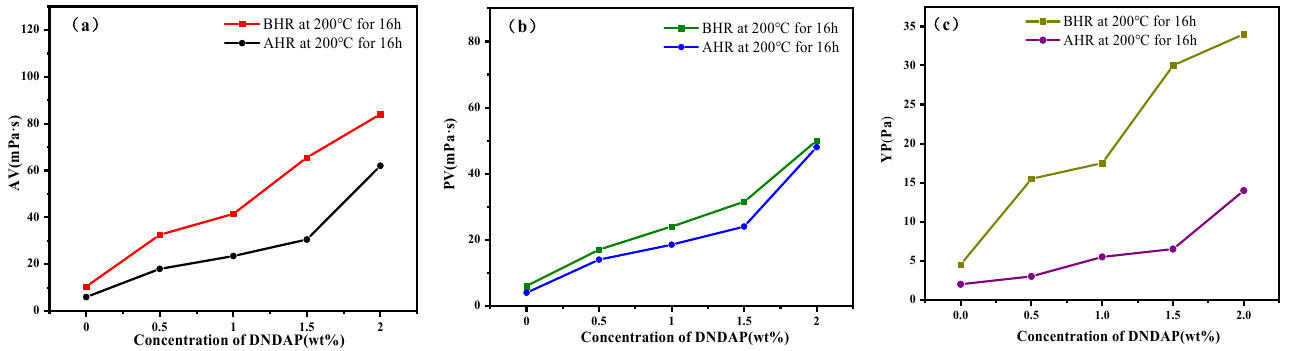
Figure 5. Rheological parameters of different concentrations of DNDAP before (BHR) and after (AHR) aging in the WBDF ( a – c